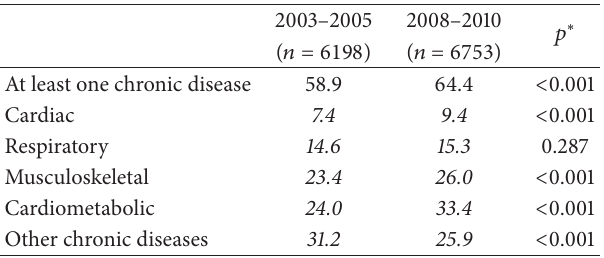
Table 2: Percentage of users with various chronic diseases,